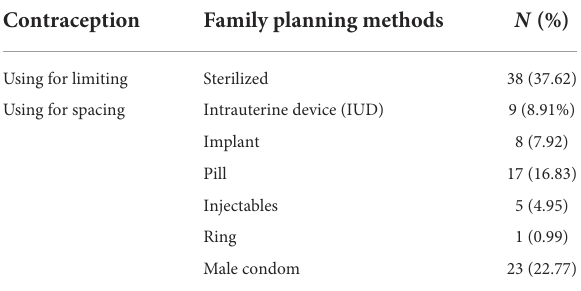
TABLE 4 Contraceptives use ( n =